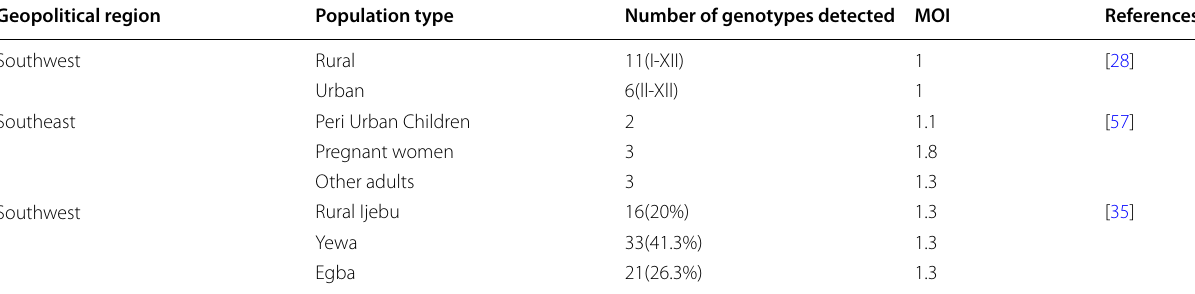
Table 3 Glutamate rich protein (GLURP) marker for P. falciparum reported in some parts of the